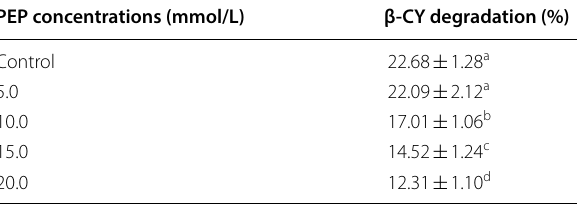
Data are presented as mean standard deviation of three replicates; the ± standard deviations are within 5% of the mean. Different letters indicate significant differences ( p < 0.05)